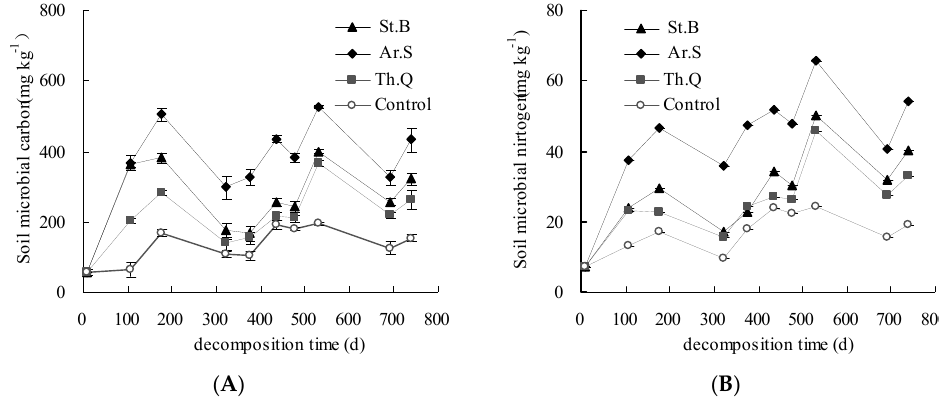
Figure 2. The change characteristics of soil microbial biomass carbon ( A ) and nitrogen ( B ).